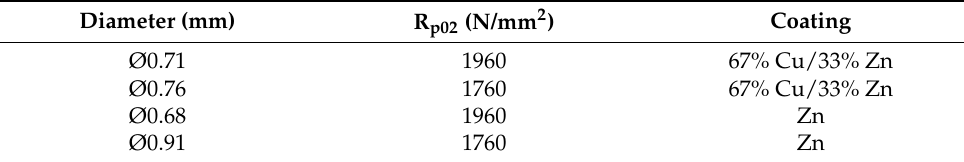
Table 2. Nominal diameter, yield strength and coating type of the